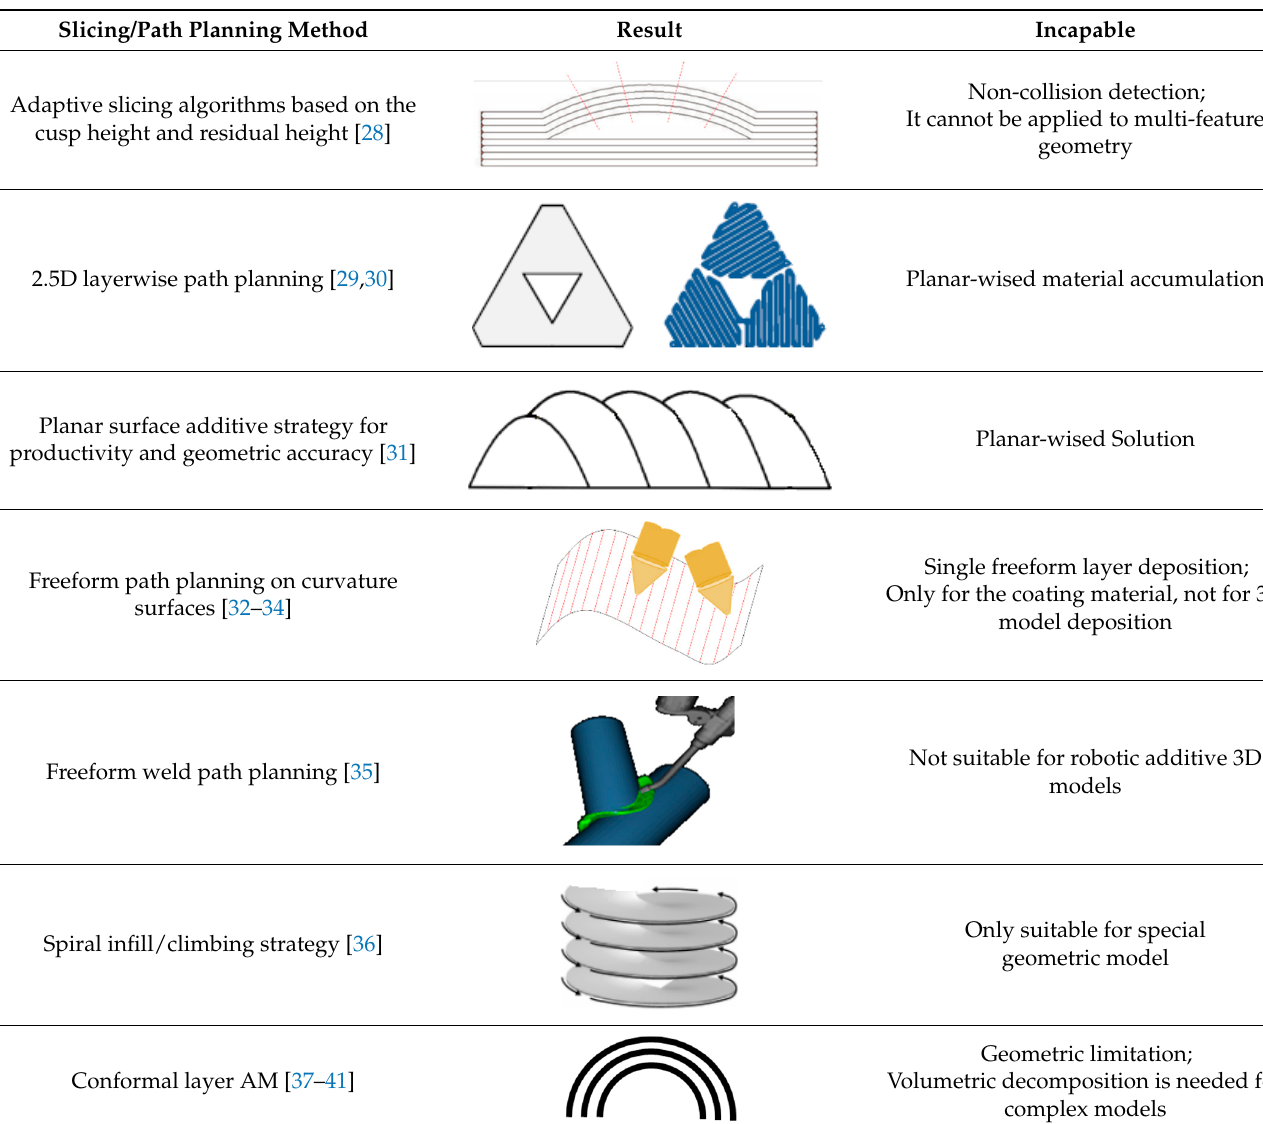
Table 3. Robotic additive slicing and path planning strategies overview.